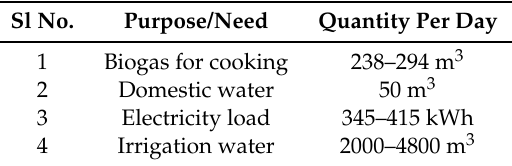
Table 3. Summary of Needs Required per day.